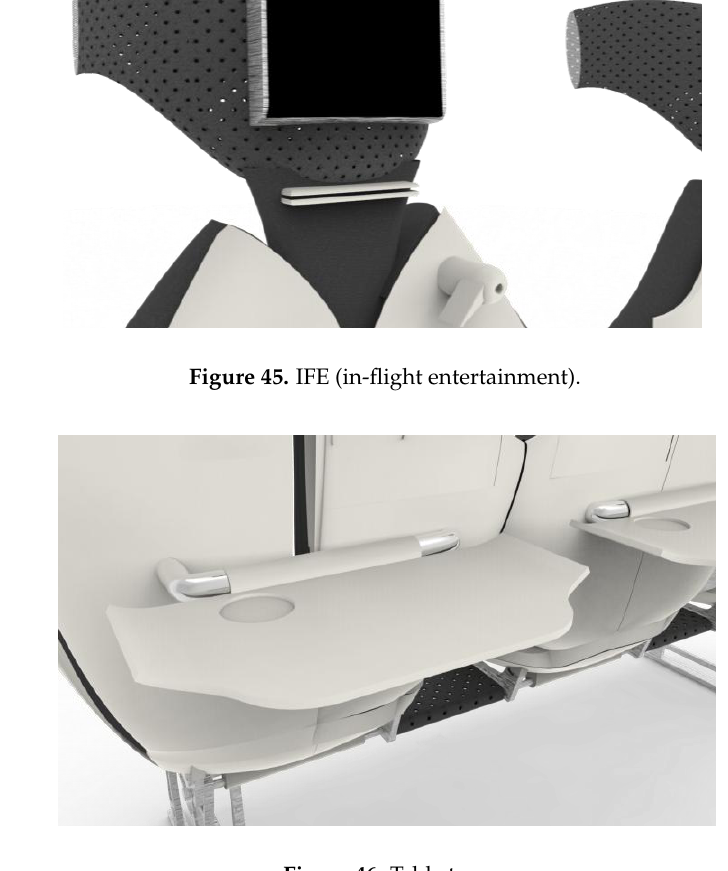
Figure 46. Table